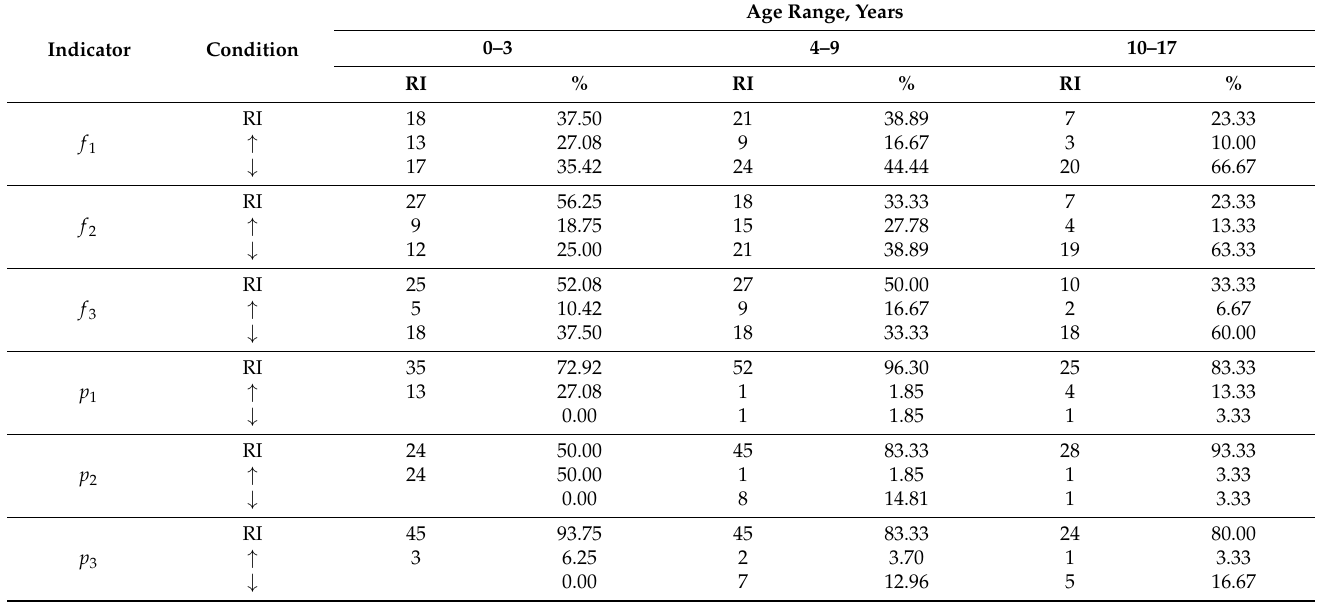
Table 3. Immunogram analysis for the state of the immune system k 1 (The symbol ↑ is used to indicate an excess of the reference interval (RI), the symbol ↓ is used to indicate a subsidence from the reference